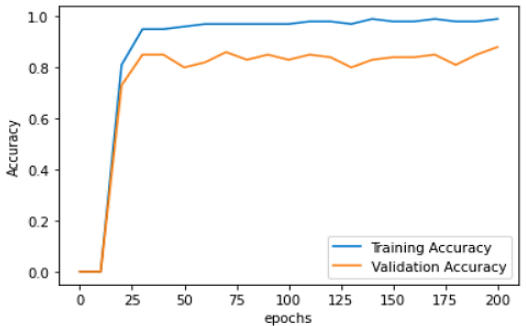
Figure 9. Training and validation learning curve.